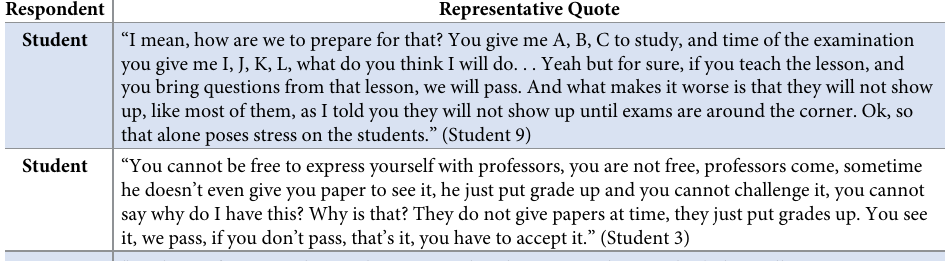
Table 3. Student experiences with medical school exams (2016).